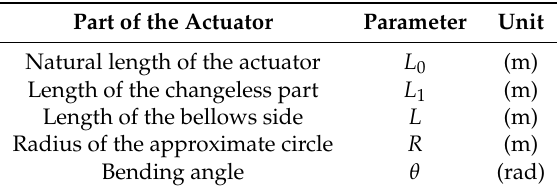
Table 1. Parameters of the actuator analysis